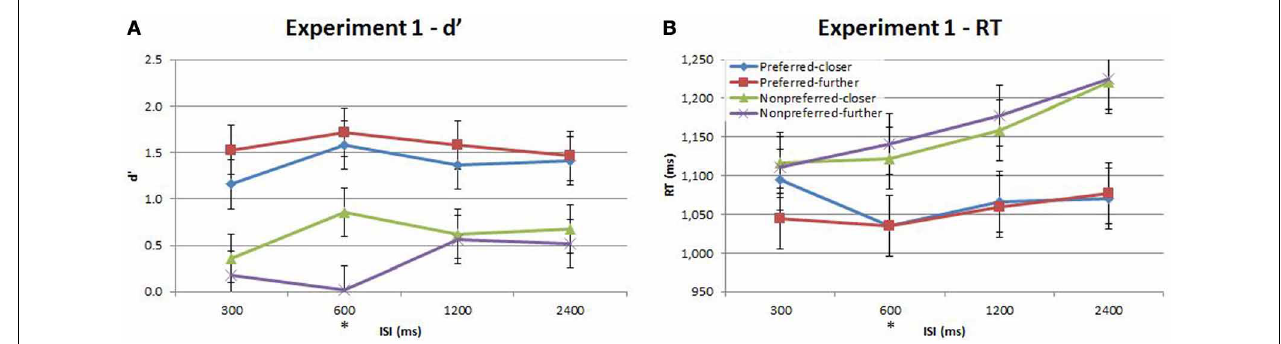
FIGURE 3 | Accuracy (d (cid:2) ) and response time (RT) for the time-order, distance and ISI analysis for Experiment 1. Each plot shows the behavioral performance across the four ISIs of four time-order/distance trial-types: preferred-closer (blue), preferred-further (red), nonpreferred-closer (green) and nonpreferred-further (purple). (A)